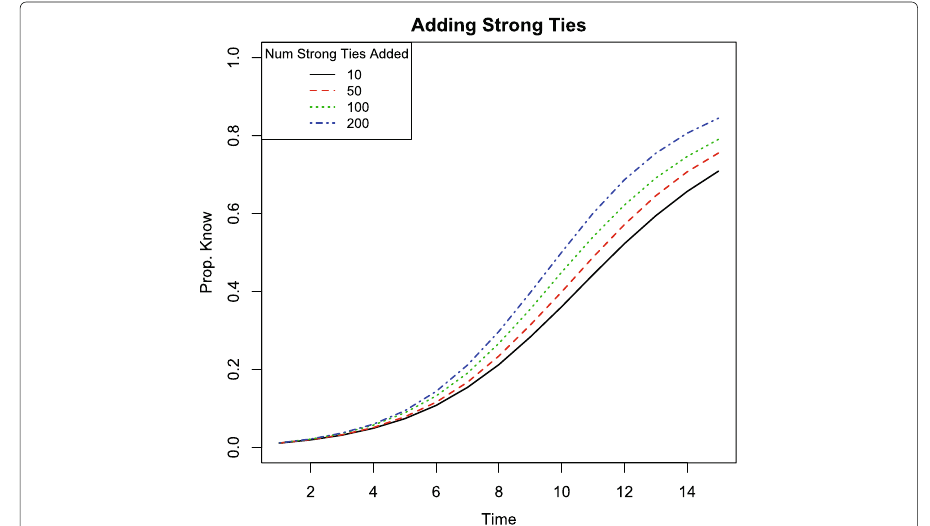
Fig. 5 Proportion of network informed by each timestep in simulated information spread in Mugana with new strong ties added to the network. Simulation parameters set to x = 2, p same = 1, and p weak = .4.